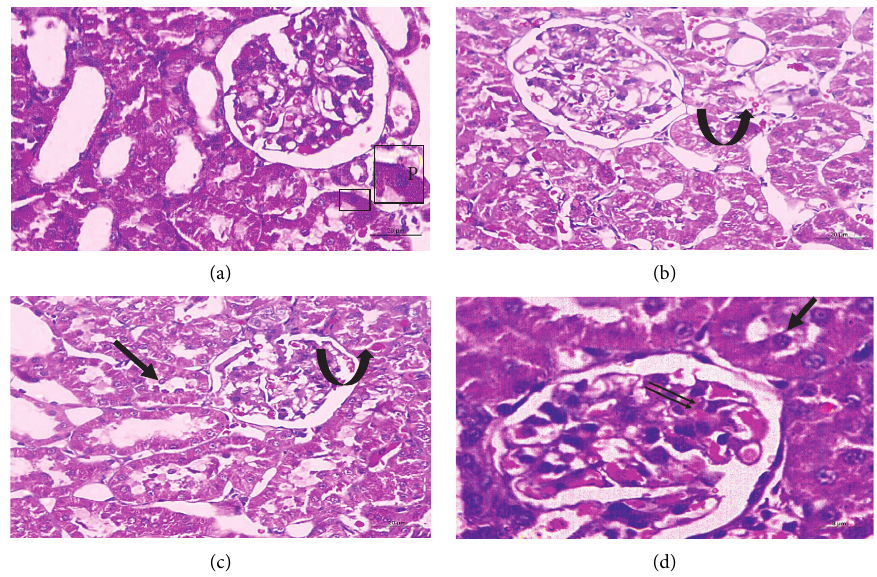
Figure 4: Representative micrographs of H&E-stained renal sections of the exercised aged group ( N � 10), clarifying amelioration of most of the age-related damaging effects. Slight exfoliation (arrows), few pyknotic nuclei P, and mild interstitial hemorrhage (arched arrows) are noted within some tubules. Few glomeruli show congested capillaries (double arrows). H&E: 40x, scale bar � 20 µ m; (d): 100x, scale bar � 8 µ m. N � number of